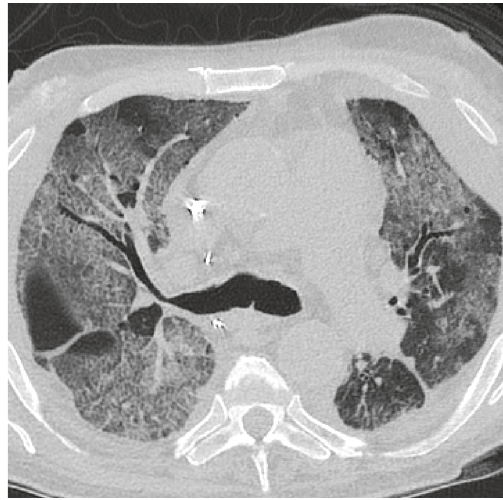
Figure 2: Transverse chest computed tomography demonstrating widespread peribronchovascularground-glass opacities throughout both lung